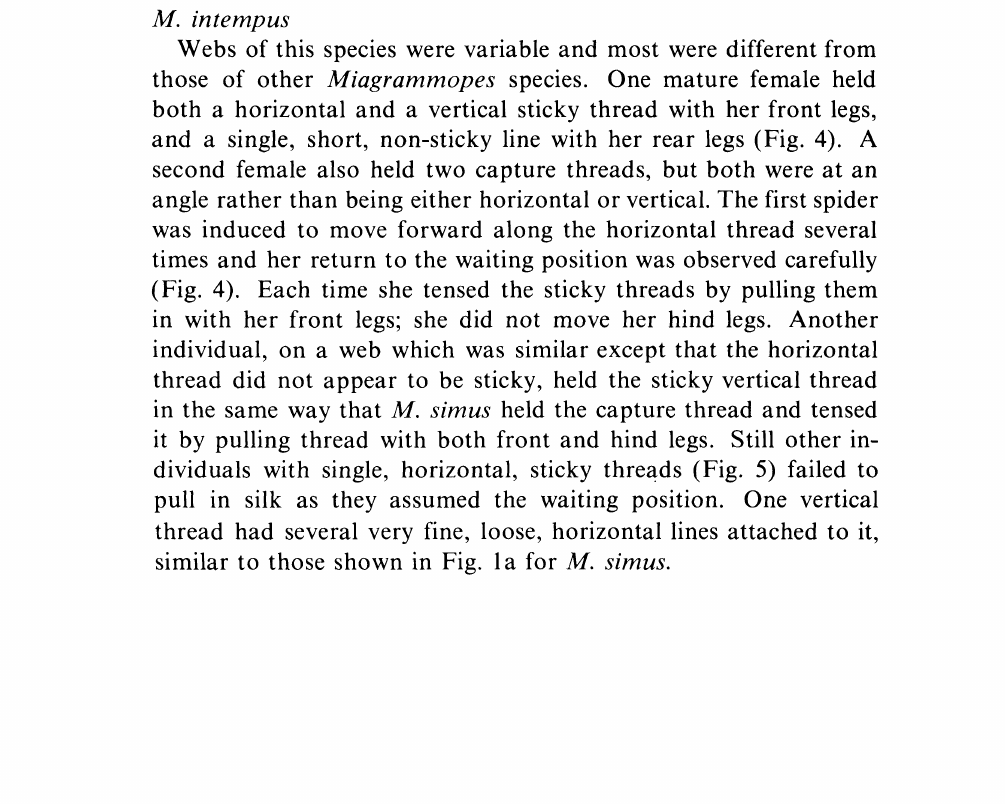
Figure 3. Miagrammopes sp. 2 in cryptic posture as it feeds and holds the non- sticky resting thread.